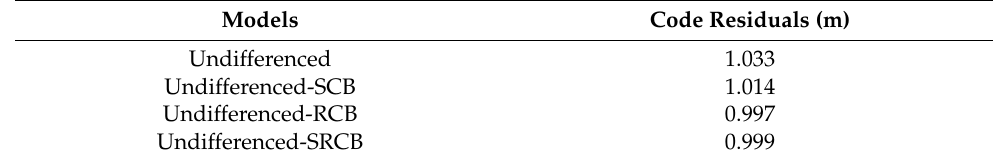
Figure 2. Time series of RMS of the code residuals for different models on DOY 031. Table 2. The mean RMS values for code residuals.